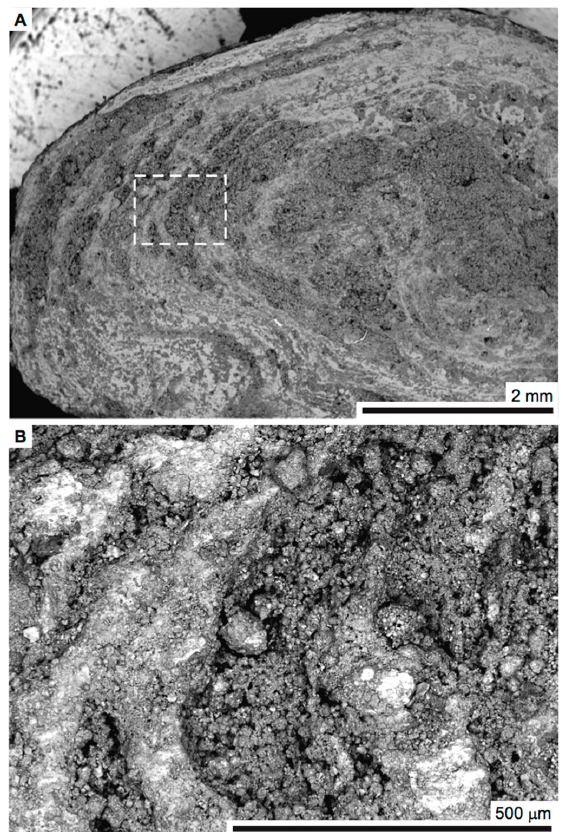
Figure 1. Scanning electron micrographs of a urinary stone from a guinea pig. The cross-section of the stone was polished, and images were recorded from backscattered electrons. ( A ) Overview and ( B ) magnified view of the dashed area indicated in ( A ).